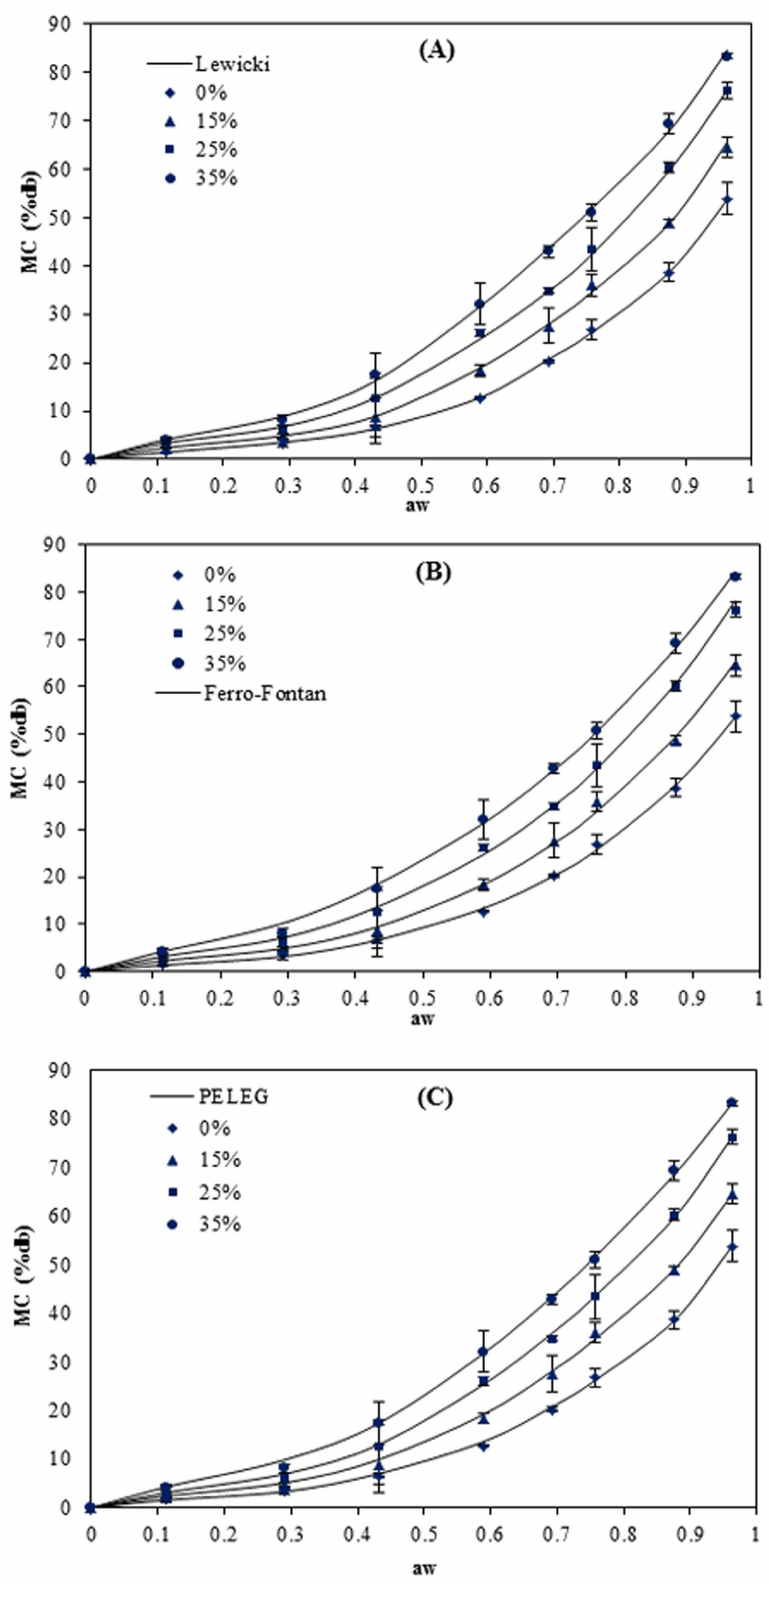
Figure 1. Equilibrium moisture sorption isotherm of pea starch film with different glycerol content ( w / w ) at 5 ˝ C. The symbols are experimental data and the lines are from the equations obtained by fitting the experimental data to Lewicki ( A ), Ferro–Fontan ( B ) and PELEG ( C )